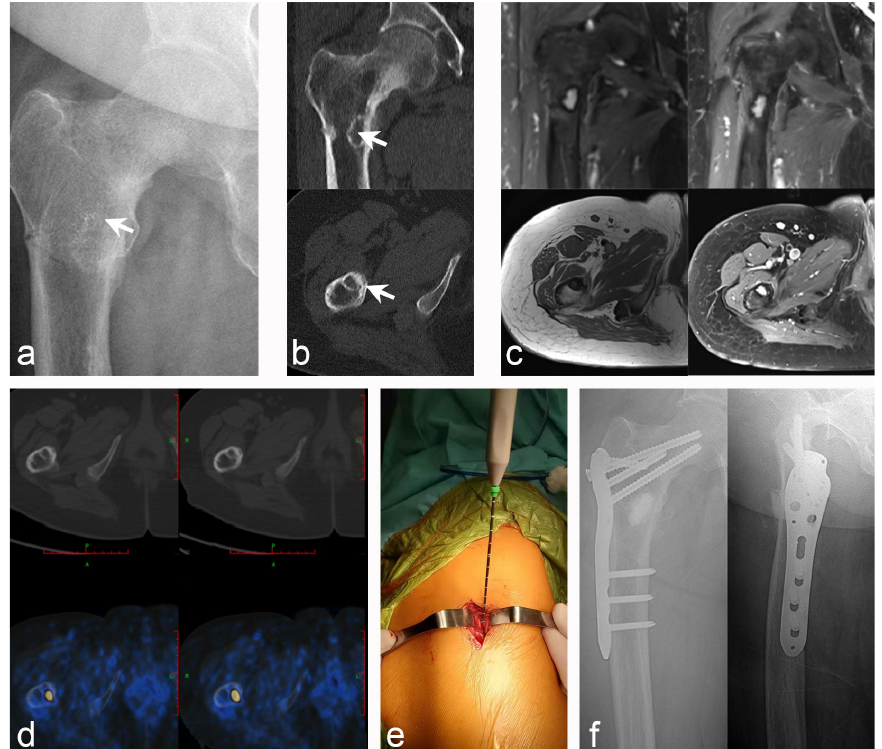
Figure 2. Case 10: PMT of the right proximal femur with pathological fracture; microwave ablation- assisted extended curettage was performed, and bone graft filling was assisted by an in-ternal fixa- tion device. ( a ) Anteroposterior X-ray of the proximal right femur (white arrow indicates the lesion). ( b ) CT scan revealed an osteolytic lesion with a marked sclerosing margin below the lesser trochan- ter of the right femur (white arrow indicates the lesion). ( c ) MRI showed low intensity on T1WI and high intensity on T2WI, with obvious en-hancement after lipid suppression enhancement. ( d ) Tc99m-octreotide PET/CT scan accurately located the lesions and showed abnormal concentration. ( e ) Intraoperative details: microwave ablation was used to inactivate the lesions at the beginning. ( f ) Postoperative X-rays of the an-teroposterior and lateral after extensive curettage of the lesion with bone graft filling and proximal femoral anatomical plate fixation. 2.4. Postoperative Management Physiotherapists instructed patients to use braces and walk with crutches to contract the affected muscles. Isometric contraction exercise was initiated one week postopera- tively, and passive functional exercise was initiated two weeks postoperatively, under the guidance of physiotherapists. Patients gradually transitioned from no-weight to half- weight to full-weight bearing. The patients’ serum ion levels were reviewed every three days postoperatively for two weeks; the bone metabolism-related hormone levels were reviewed simultaneously. Patients were followed up with at 6 and 12 weeks postopera- tively and then at three-month intervals for the first two years, every six months for the next three years, and annually thereafter. The follow-up primarily evaluated the patients’ oncological prognosis, radiological results, bone healing, serum ion levels, limb function, and pain levels and recorded the occurrence of complications. 2.5. Statistical Analysis SPSS v. 26.0 (SPSS Inc., Chicago, IL, USA) was used for statistical analysis. The meas- urement data are expressed as mean ± standard deviation. Descriptive statistical analysis